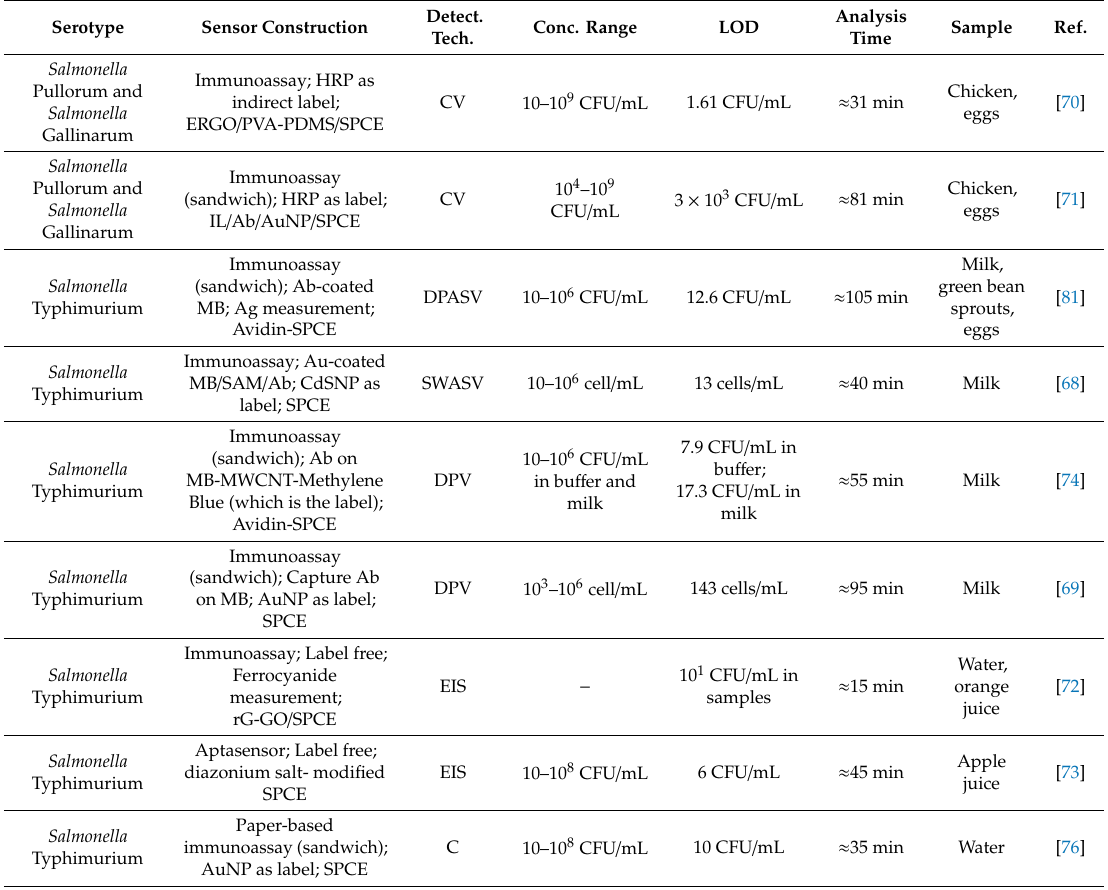
Table 2. SPE-based sensors for Salmonella and Listeria detection in foods. Serotype Sensor Construction